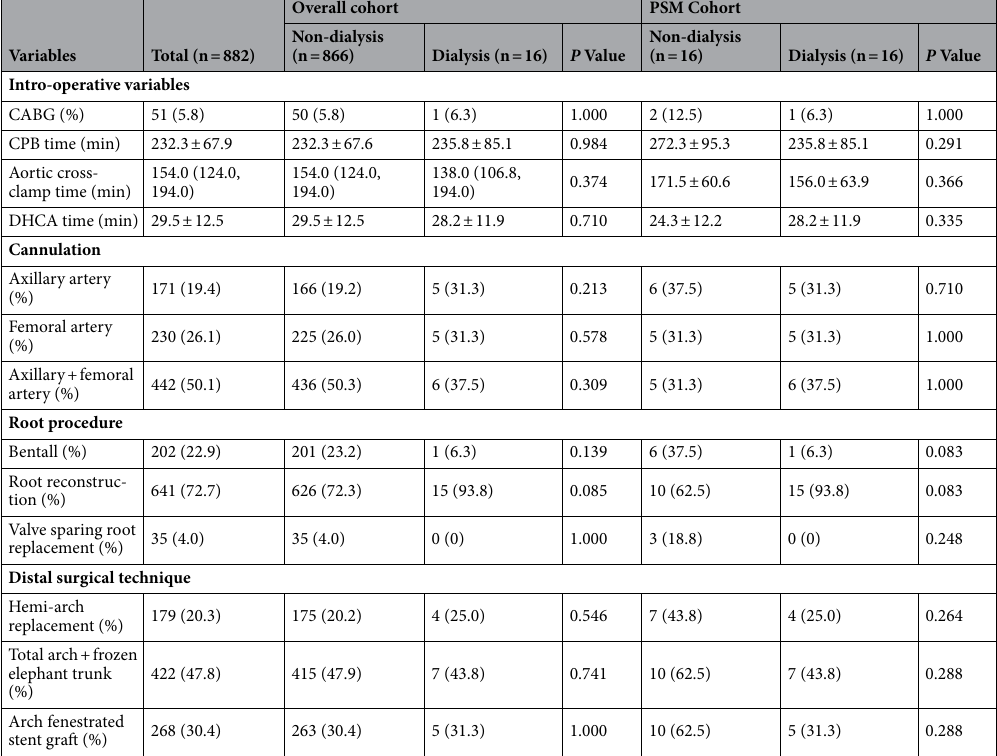
Table 3. Comparison of operative variables. Values for categorial variables are given as count (percentage); values for continuous variables are given as median (interquartile range) or mean ± standard deviation. MVR mitral valve replacement, MVP mitral valvuloplasty, TVP tricuspid valvuloplasty, CABG coronary artery bypass graft, CPB cardiopulmonary bypass, DHCA deep hypothermic circulatory arrest, PSM propensity score